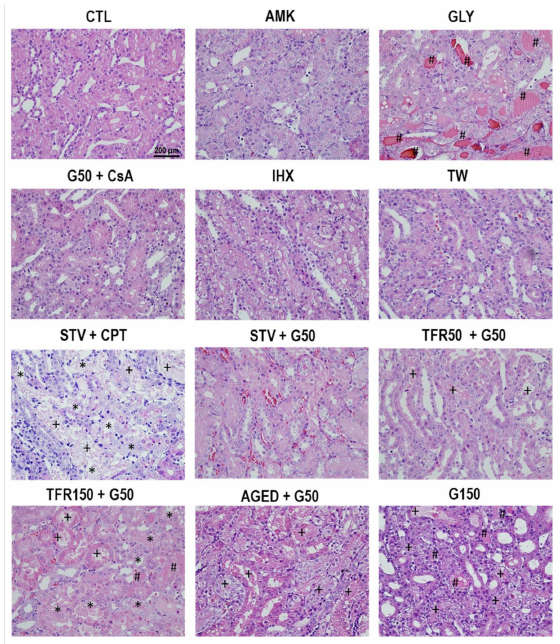
Figure 2. Outer medullary histology. Representative images of the renal outer medulla of rats from the AKI models included in the study. (+ luminal debris, * tubular necrosis, # tubular